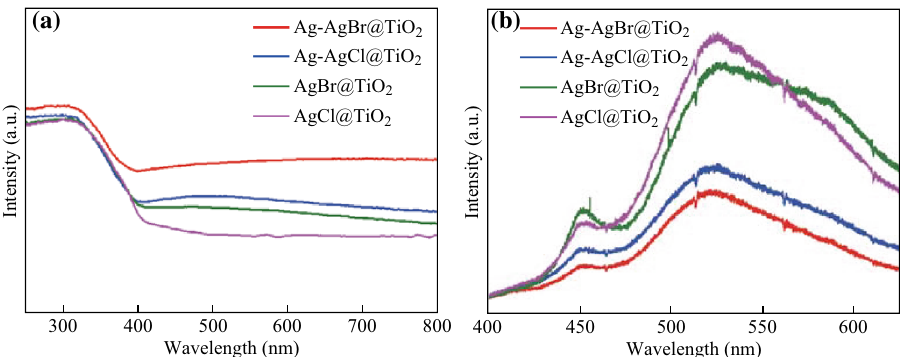
Fig. 5 a UV–Vis absorption spectra and b PL spectra of Ag–AgCl@TiO 2, Ag–AgBr@TiO 2 , AgCl@TiO 2 and AgBr@TiO